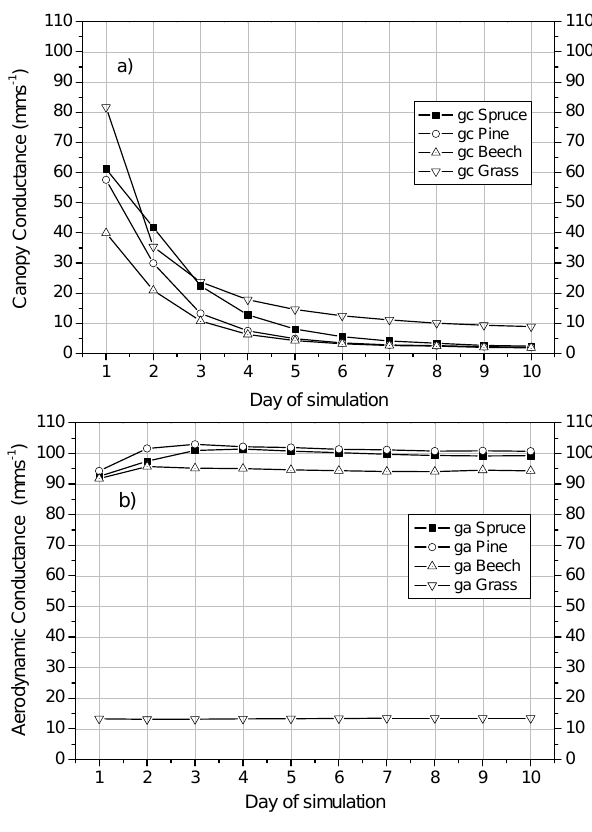
Fig. 13. Canopy (a) and aerodynamic conductance (b) (Mean of half hour averages between 10:00 and 15:00LT) during a summery dry period. HIRVAC simulations for spruce, pine, beech and grass with the stand parameters as described in Fig.